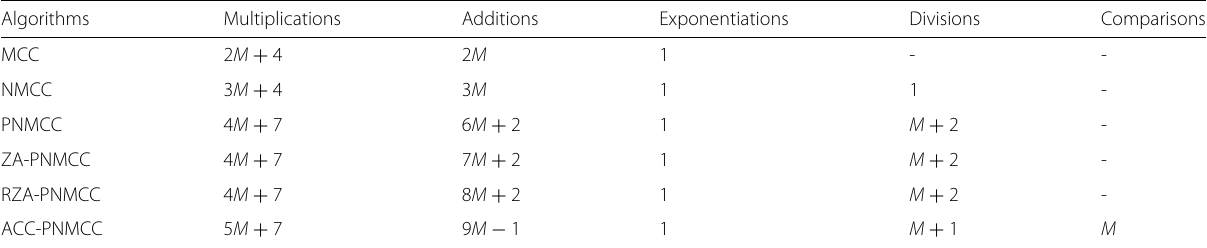
Table 1 Numerical complexities of the algorithms Algorithms Multiplications Additions Exponentiations Divisions